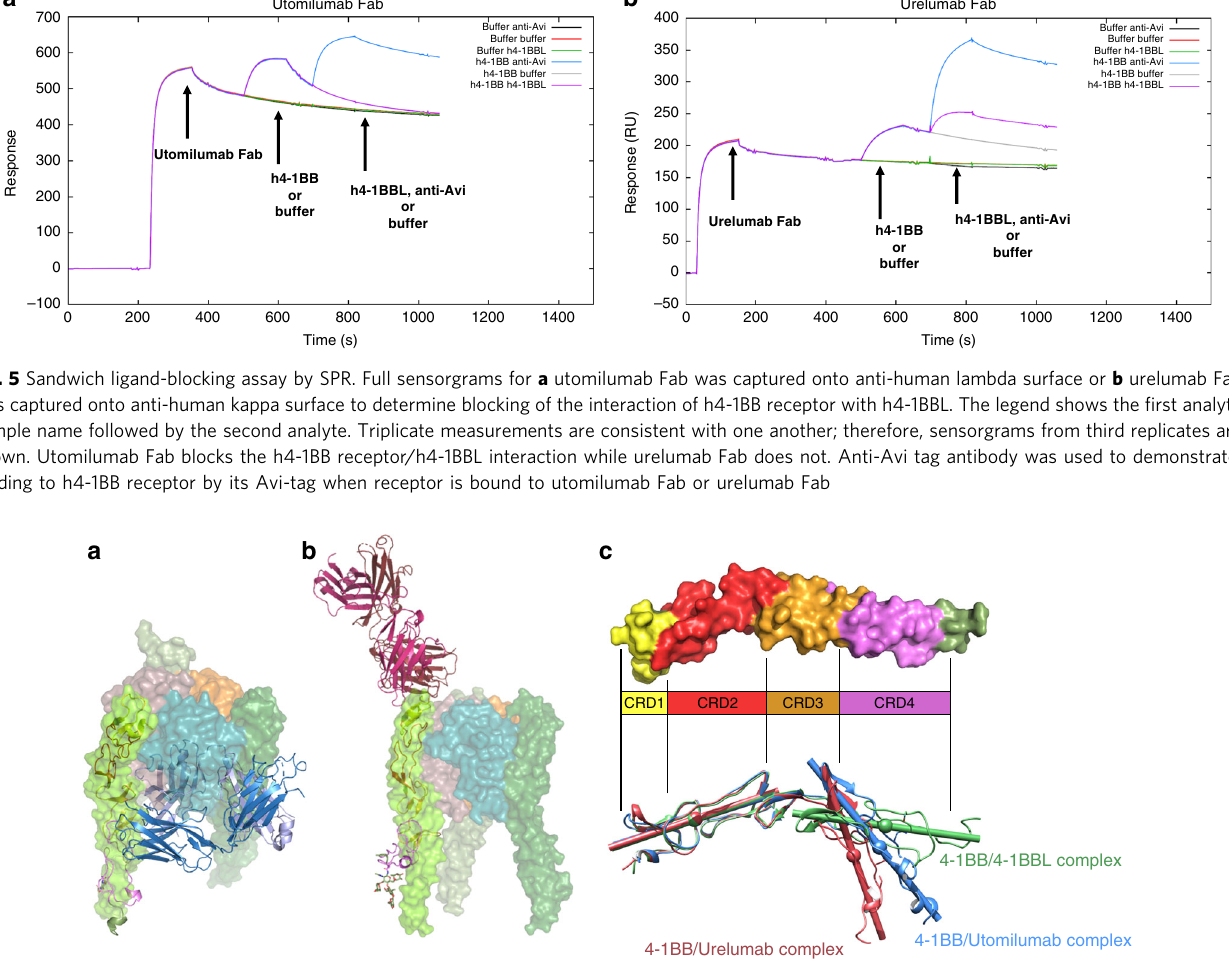
Fig. 6 Superposition of the 4-1BB/4-1BBL complex with the antibody-bound structures and fl exibility of human 4-1BB. a The structure of the utomilumab Fab bound to the 4-1BB receptor (cartoon representation) overlaid on the structure of the 4-1BB/4-1BBL complex (transparent surface representation) aligning on CRDs 1 and 2 of the receptor. Light chain of Utomilumab (light blue) clashes with the ligand. b The structure of the urelumab Fab bound to 4- 1BB (cartoon representation) overlaid on the structure of the 4-1BB/4-1BBL complex (surface representation) aligning on CRDs 1 and 2 of the receptor. Urelumab binding to 4-1BB is compatible with ligand co-binding allowing for the formation of higher order aggregations. c Flexibility of the the human 4-1BB receptor. Receptor structures from the 4-1BB/4-1BBL complex, the 4-1BB – utomilumab complex, and the 4-1BB – urelumab complex were aligned on CRDs 1 and 2. Centroid axes for CRDs 1 – 2 or CRDs 3 – 4 were calculated using UCSF Chimera and displayed as rods. Both antibody-bound structures show a pivot point at the junction between the A2 and A1 motifs of CRD3 highlighting the signi fi cant range of motion possible in h4-1BB receptor